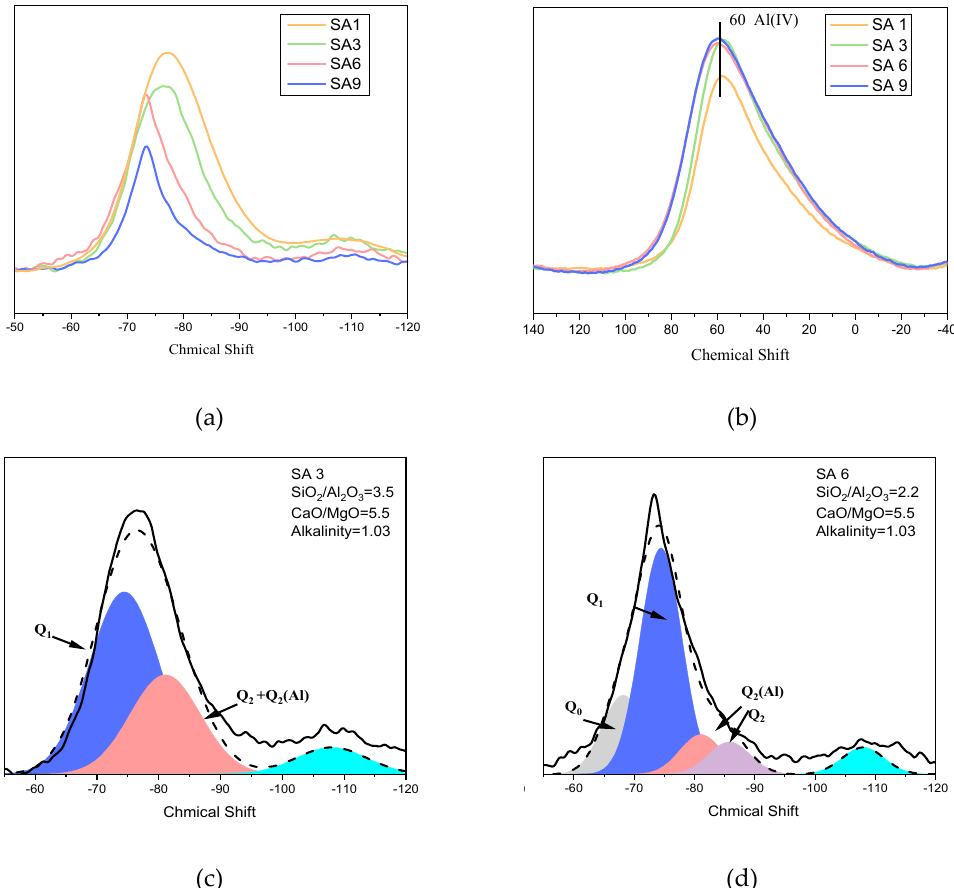
Figure 3. 29 Si MAS NMR spectra of slag with di ff erent S / A ratio: ( a ) unhydrated SA1, SA3, SA6, and SA9; ( b ) 27 Al MAS NMR spectra of slag with di ff erent S / A; ( c ) the deconvolution of unhydrated SA3; ( d ) the deconvolution of unhydrated SA6.